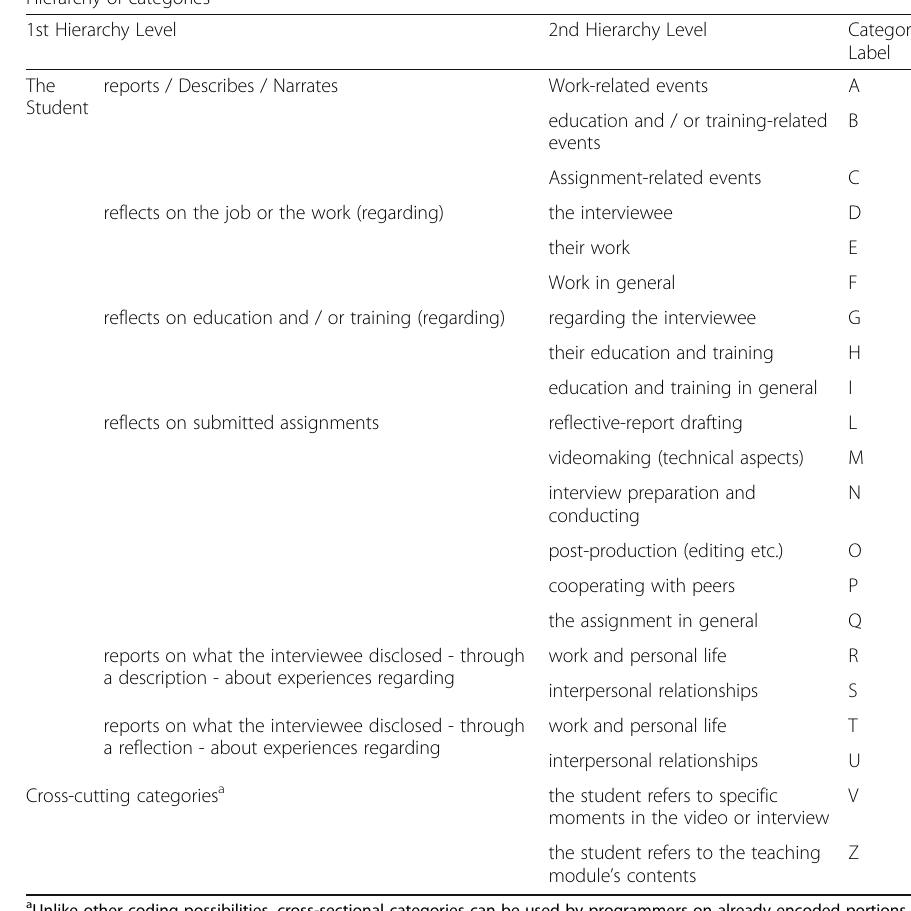
Table 2 The coding system and its categories Hierarchy of